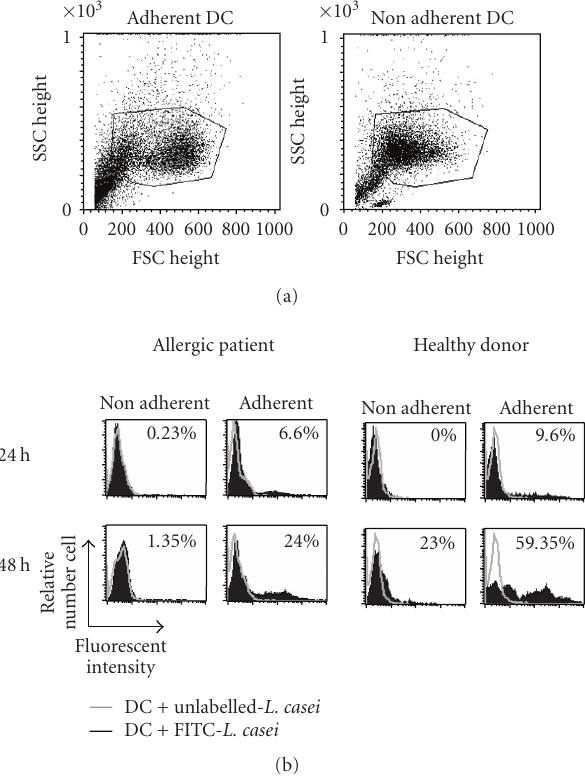
Figure 2: DC take up FITC-labelled L. casei through an intestinal ep- ithelial layer . Monocytes from allergic patients and healthy donors were di ff erentiated in DC in the presence of GM-CSF and IL-4 for 5- 6 days. Cells were then pulsed with unlabelled or with FITC-labelled L.casei (ratio bacteria/DC: 100/1) for 24 or 48 hours in the presence of an intestinal epithelial layer. DC, adherent and nonadherent to the filter, were harvested and analyzed by flow cytometry. (a) The percentage of FITC-positive cells is evaluated into the gate repre- sented on the dot plots. (b) Open histograms represent the fluo- rescence of DC incubated with unlabelled L. casei , and closed his- tograms represent the capture of FITC-labelled L. casei by DC. The percentages of FITC-positive cells are indicated. One representative experiment is shown for both donor